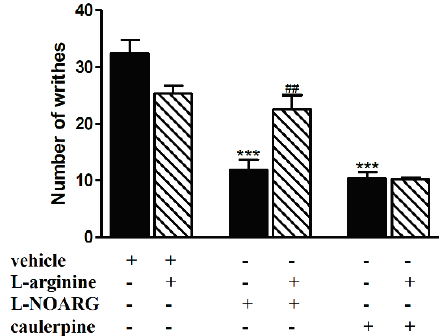
Figure 4. Effect of L -arginine on the antinociceptive effect of caulerpine in the acetic acid model of nociception. Black columns: treatments alone; hatched columns: pretreatment and treatments. The results are expressed as means ± S.E.M. of six animals. (One-way ANOVA followed by Bonferroni’s test). *** p < 0.001 compared to vehicle; ## p < 0.001 compared to L